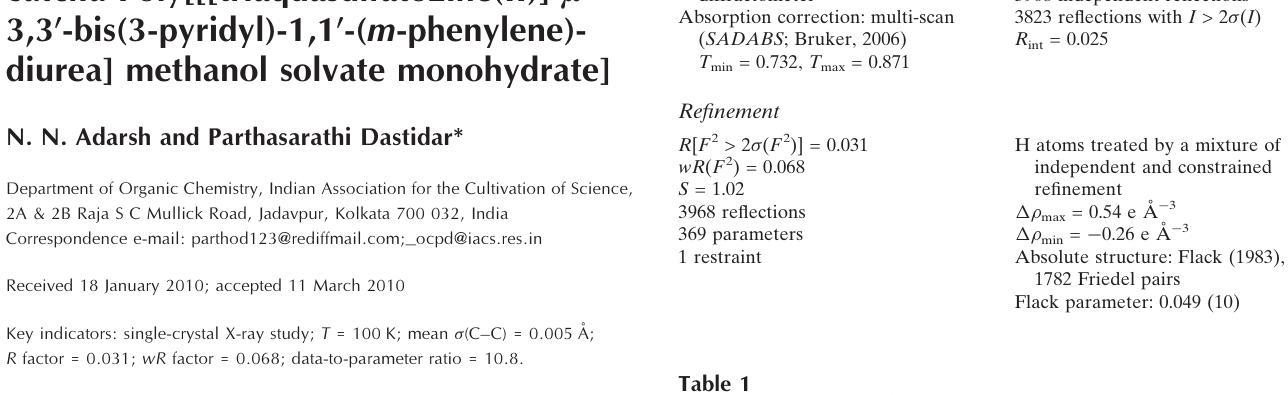
Selected bond lengths (A˚ ).